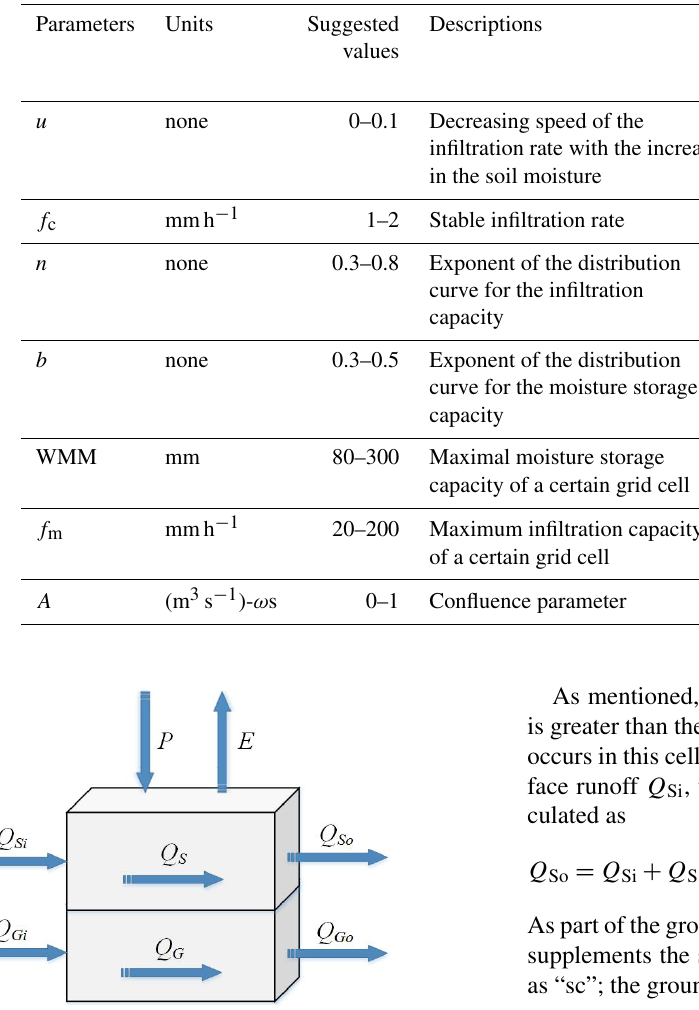
P a is the influenced precipitation during the early phase of the grid (mm), W m is the average storage capacity of the grid (mm), W (cid:48) is the storage capacity of the grid at the max- m imum point (in mm), and b is the exponent of the water stor- age capacity